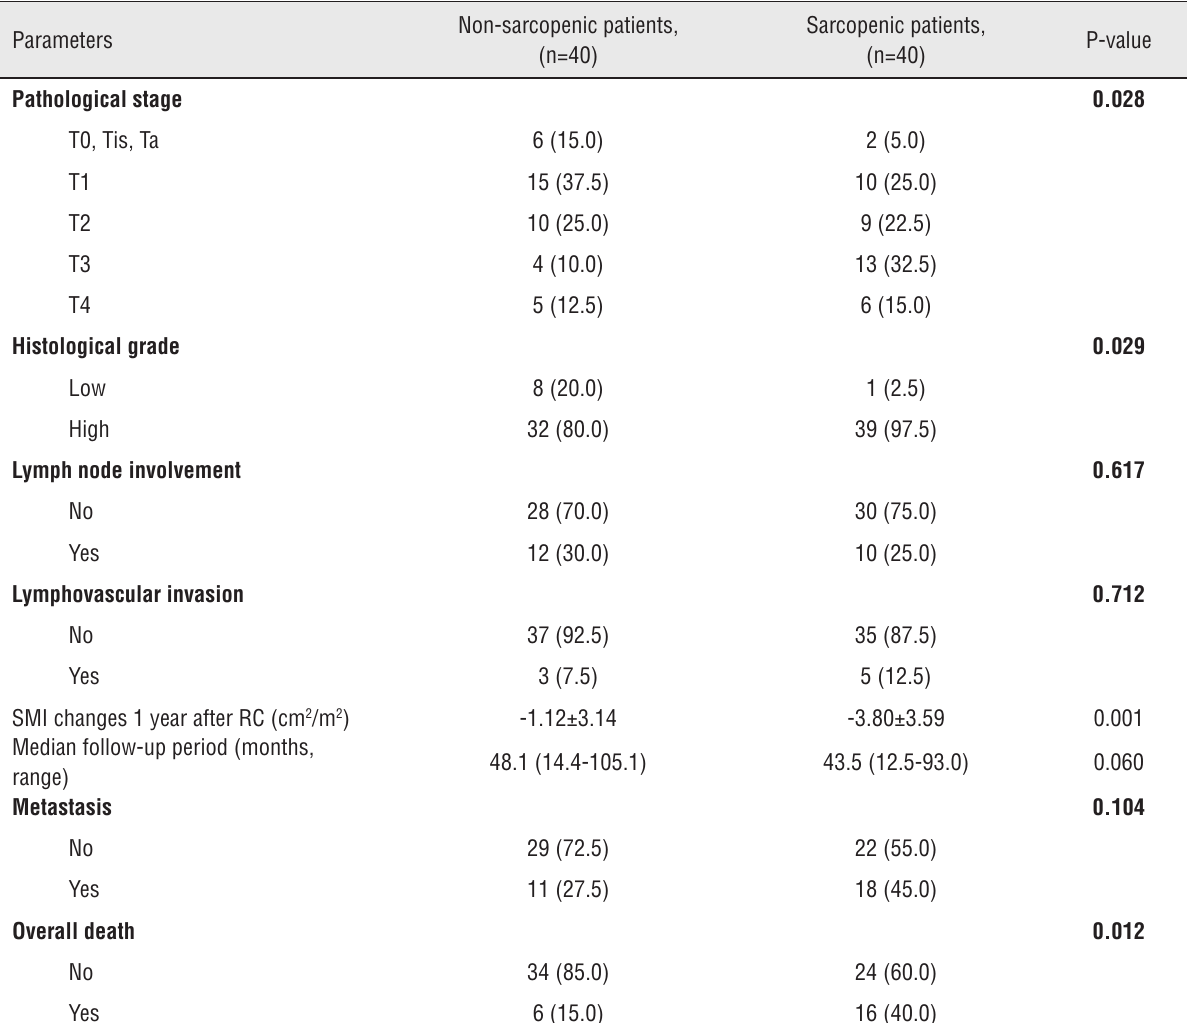
Table 2 - Comparison of clinicopathological variables according to skeletal muscle index one year after radical cystectomy. Non-sarcopenic Parameters